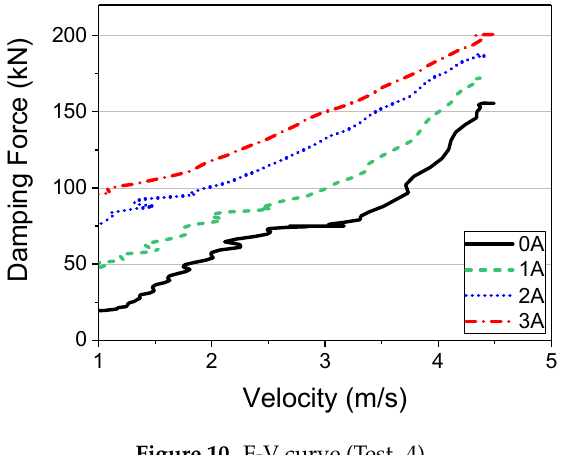
Figure 10. F-V curve (Test. 4). Table 2. Values of the coefficients for the estimation of the F-V model with different inputs.